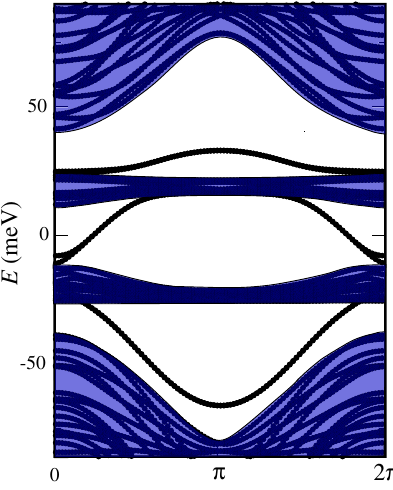
FIG. 7. The band structure of twisted bilayer graphene at θ ≈ 1 . 08 ° in a ribbon geometry with open boundary conditions. The atomic structure inside the unit cell (replicated 7 times along the x direction) has been deformed with the A 1 -symmetric moir´e phonon mode. With a mean deformation amplitude of ≈ 1 . 14 m Å, that mode is so strongly coupled to open a large electronic gap at charge neutrality point of ≈ 25 meV. The bulk bands have been highlighted in blue to emphasize the presence of edge states both within the phonon-driven FBs gap and the gaps above and below